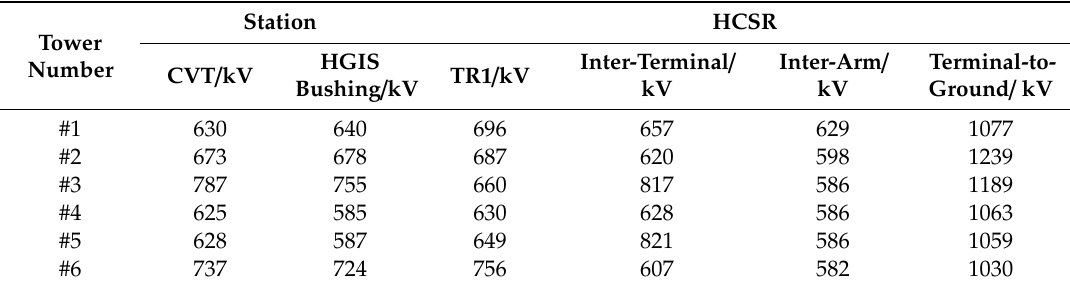
Figure 7. Inter-terminal and inter-arm overvoltage of the HCSR. Table 9. Overvoltage of the equipment in current limiting state.